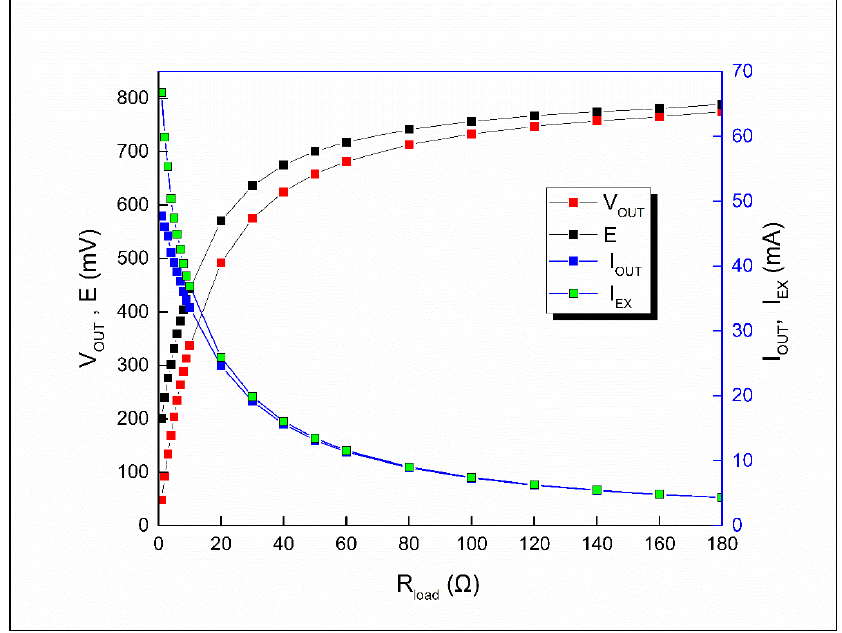
Figure 8. Dependence of OUT V , E , OUT I , and EX I on load resistance.